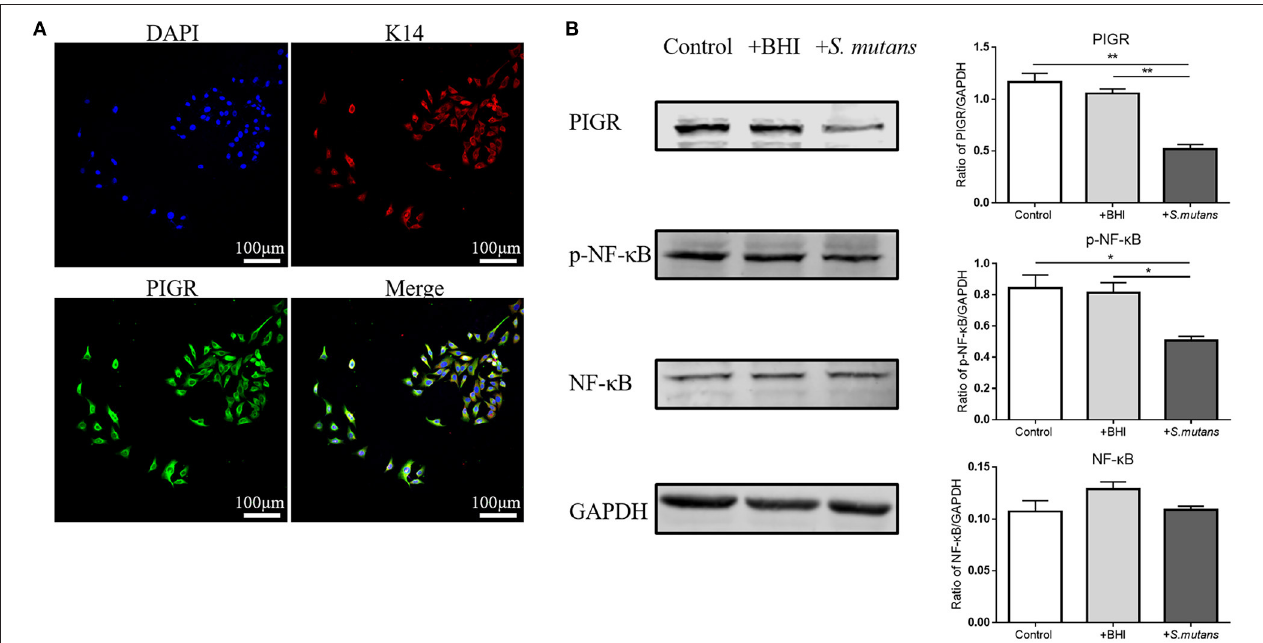
FIGURE 6 | The effect of Autism spectrum disorders (ASD) -related Streptococci on the polymeric immunoglobulin receptor (PIGR) protein level and the NF- κ B signaling pathway in the human salivary gland (HSG) cells. (A) Cytokeratin 14 and PIGR expression in HSG cells was validated by immunofluorescent staining. Representative images of similar results are shown. (B) Control group: normal HSG cells; + BHI group: HSG cells treated with blank brain heart infusion broth; + S. mutans group: HSG cells co-incubated with heat-killed Streptococcus mutans . Western blotting was used to determine the protein levels of PIGR, NF- κ B, and phosphorylated NF- κ B (p-NF- κ B). Representative pictures of western blots with similar results and the quantification of protein levels are shown. The above data are presented as the mean ± SEM, n = 3 per group, One-way ANOVA, * denotes p < 0.05 ** denotes p <